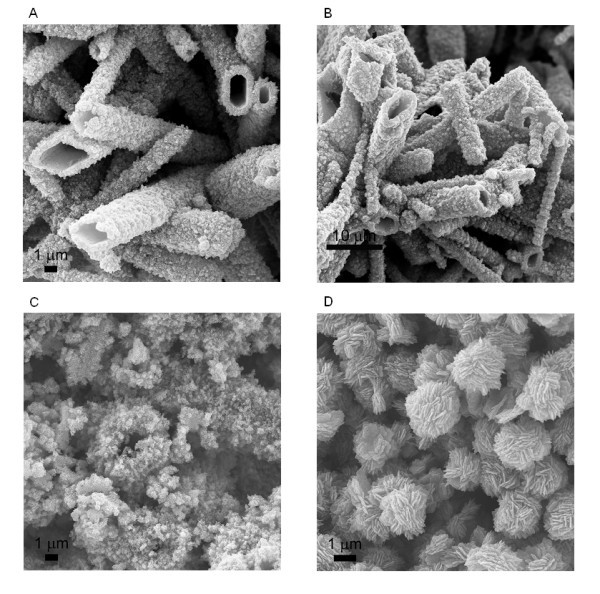
FESEM images of ZnO nanostructures. Obtained from the precipitation reaction between ZnSO4·7H2O and (NH4)2CO3 with the  ratio at (A) 2.4:1.0, (B) 2.0:1.0, (C) 1.6:1.0, and (D) 1.0:1.0.